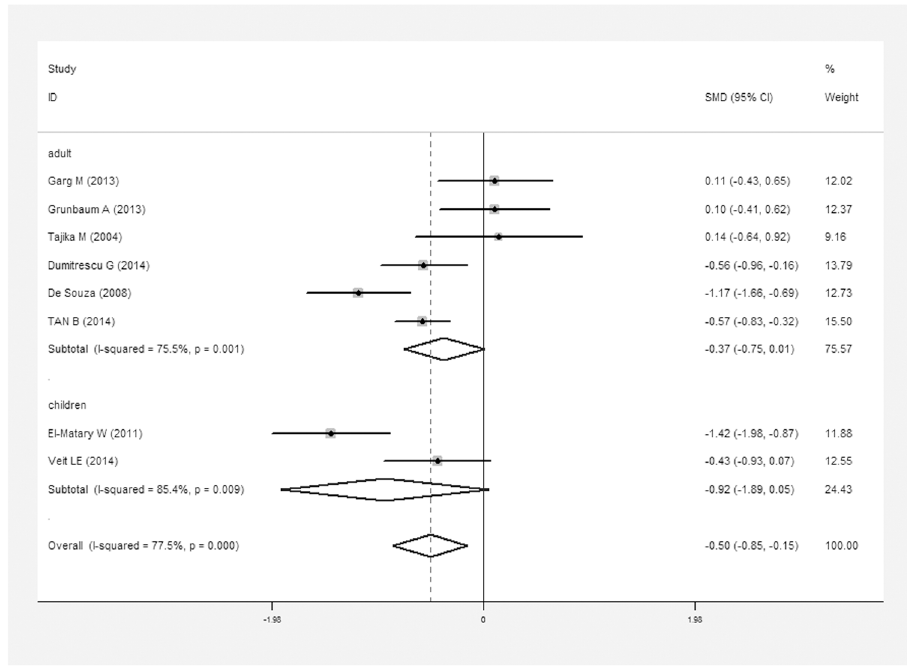
Fig 3. Meta-analysis of studies reporting 25(OH)D levels in UC patients vs. controls, a standardized mean difference with a 95% confidence interval and weight percentage. Subtotals of adults and children, and overall